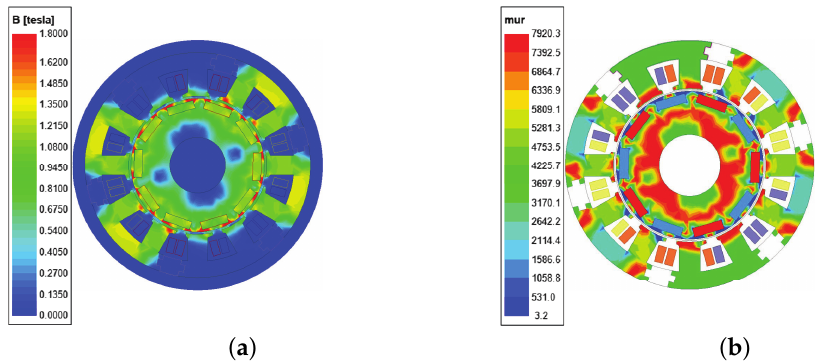
Figure 11. Motor FEA results at ( i d , i q ) = ( 60,0 ) A : ( a ) distribution of the flux density and ( b ) distri- bution of the relative